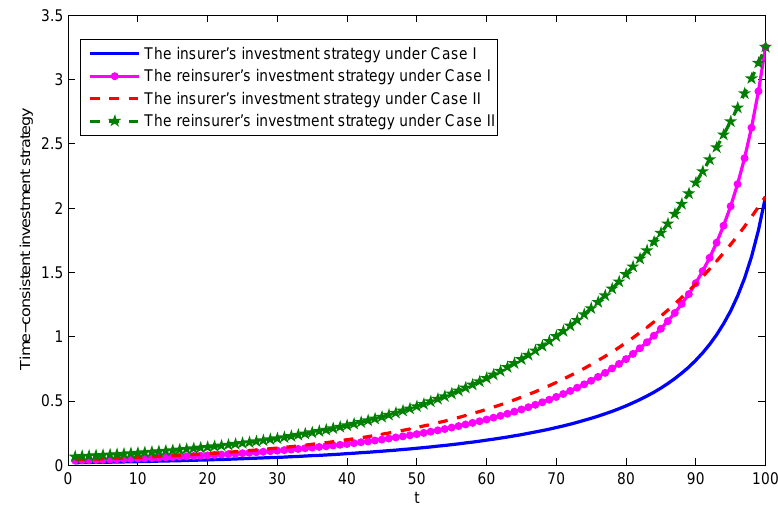
Figure 2. Time-consistent investment strategy for the insurer ( α = 0.6 and T =